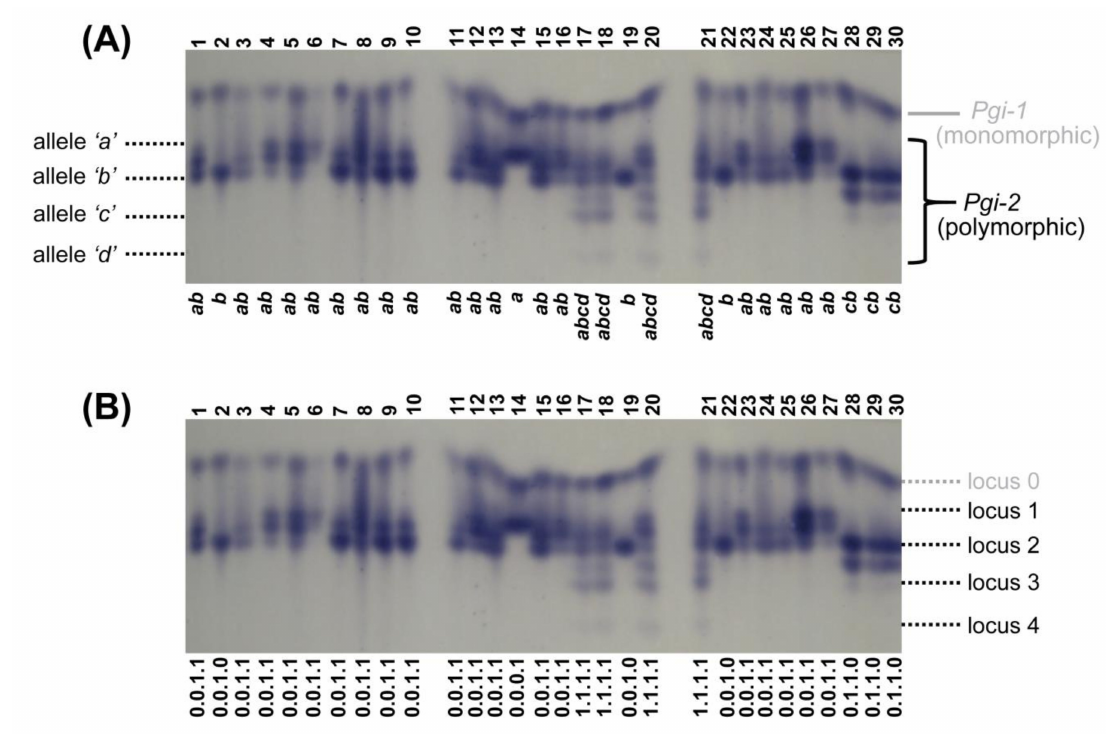
Figure 2. Zymogram of the PGI (phosphoglucoisomerase) enzyme in 30 individuals (mostly collected from El Labrado subpopulation) of Centaurea tentudaica , where two allozyme loci are identified (the faster-migrating Pgi-1 , monomorphic, and the slower-migrating Pgi-2 , polymorphic). The two approximations that are explained in Section 2 to interpret the banding patterns are outlined here (( A ) treating the data as codominant; ( B ) treating the data as dominant). Through the first approach, up to four alleles can be identified for the Pgi-2 (‘ a ’, ‘ b ’, ‘ c ’, and ‘ d ’). As we were not able to estimate the allele dosage (that is, the number of copies of each allele) in all the individuals, we assigned ‘allele phenotypes’ (indicated at the bottom of the zymogram) instead of true genotypes. Please note that individuals 3–13 are all codified as ‘ ab ’, but they might actually correspond to different genotypes: Individuals 7, 9, and 10 could be ‘ aabbbb ’ or ‘ abbbbb ’ but, instead, individuals 4, 5, and 12 are probably ‘ aaabbb ’ or even ‘ aaaabb ’. Through the second approach, each of the four alleles that can be identified in the Pgi-2 is treated as a dominant locus, so if present, it is codified as ‘1 (cid:48) , if absent, as ‘0 (cid:48) . Hence, an individual that in the upper part of the graph is codified as ‘ ab ’, in the lower part of the graph is codified as ‘0.0.1.1 (cid:48) , while an individual with an allele phenotype ‘ abcd ’ would be ‘1.1.1.1 (cid:48)